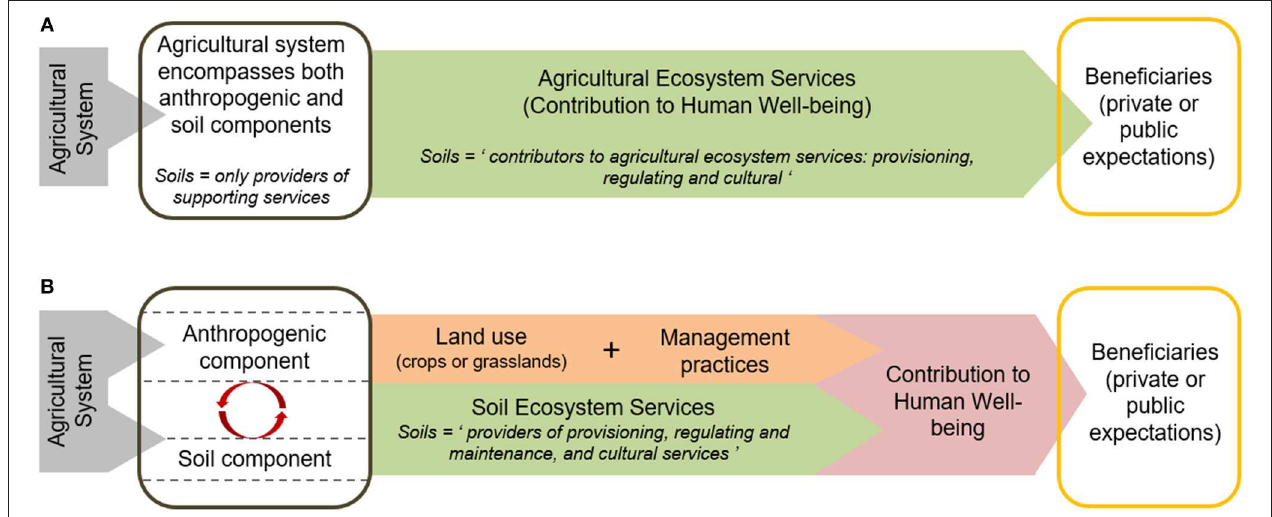
FIGURE 1 | Two alternative representations of soils in agricultural systems and their outcomes that regard soils as (A) contributors to agricultural ecosystem services or (B) providers of soil ecosystem